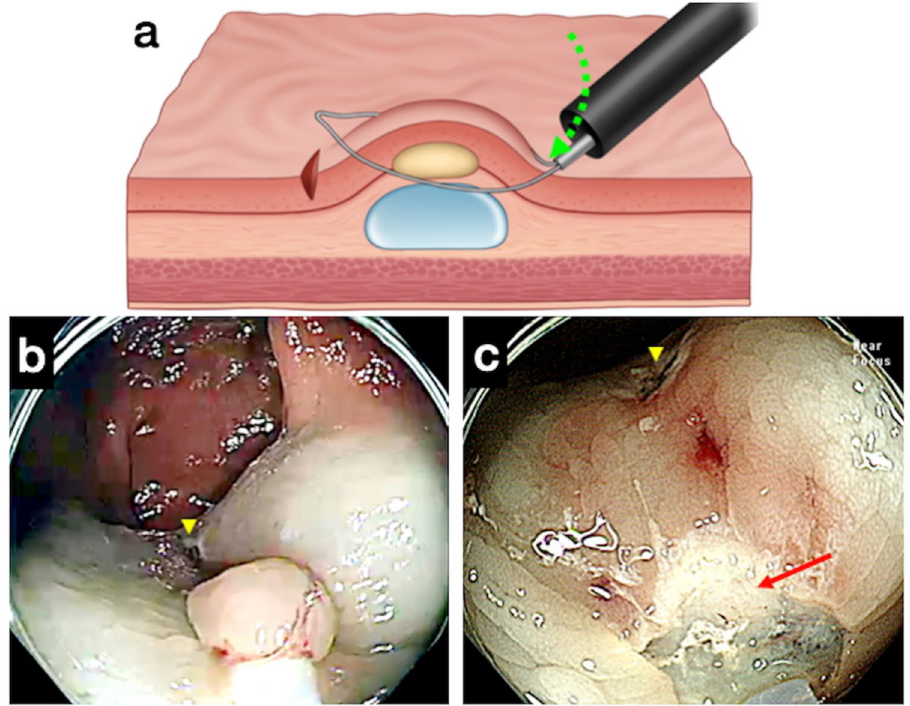
Figure 3. A failed case of anchored snare-tip endoscopic resection for an established rectal neuroendocrine tumor (NET). ( a ) If the anchoring is loosened because of insufficient pressure toward the anchoring point (see the green dotted arrow), the snare will slip at the oral side of the lesion and the rise of the neuroendocrine tumor (NET) secondary to the load motion will not happen. ( b ) Anchoring was not maintained during snaring, and the snare slipped on the oral side. The yellow arrowhead indicates the mucosal incision site for anchoring. ( c ) Remnant NET tissue was observed after the anchored snare-tip endoscopic mucosal resection (see the red